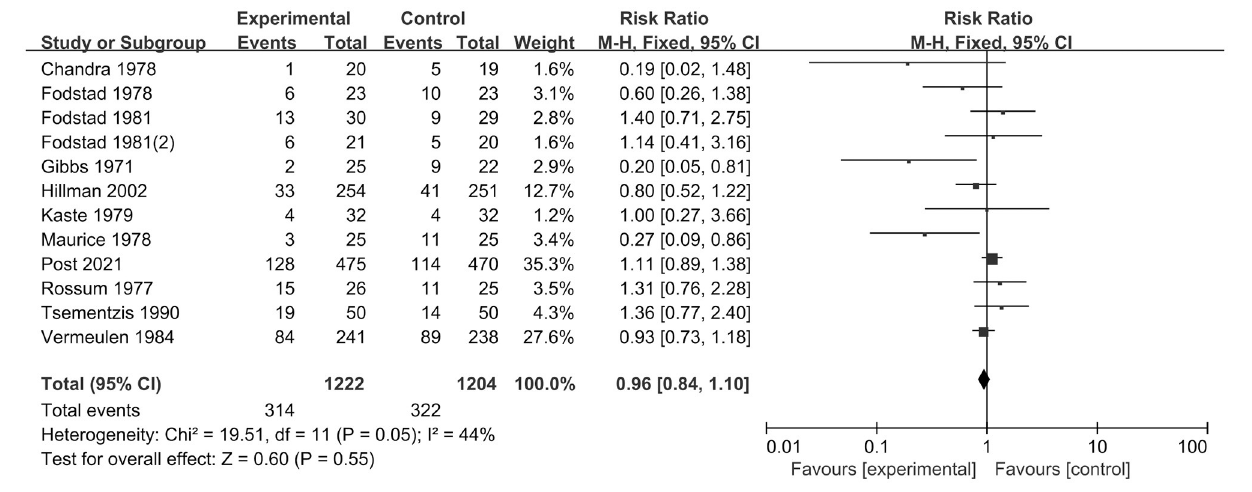
Rebleeding In total, 12 RCT studies, including 2,851 patients, compared the occurrence of rebleeding in the tranexamic acid and